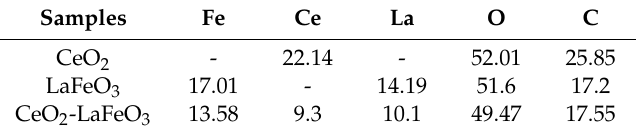
catalytic degradation of nitrosamine